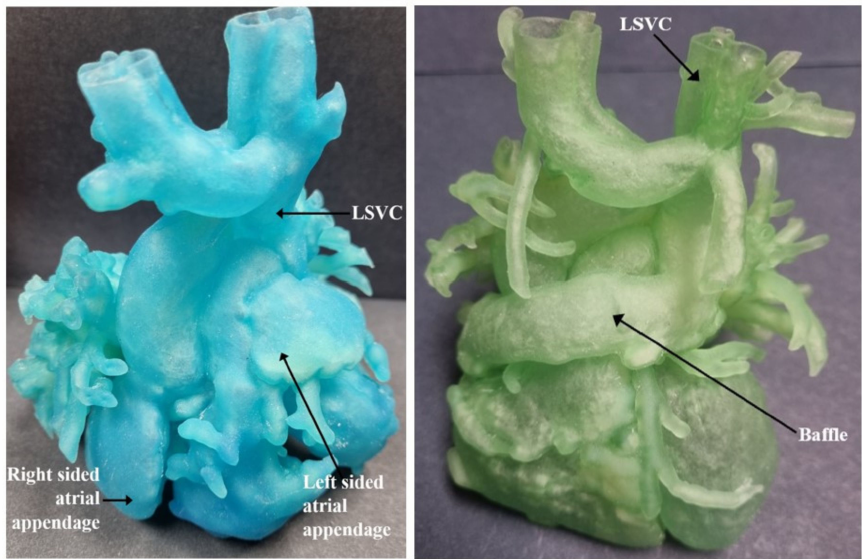
Figure 7. Comparison of pre-operative 3D cardiac model and post-operative 3D cardiac model to demonstrate baffle connection. LSVC = left superior vena